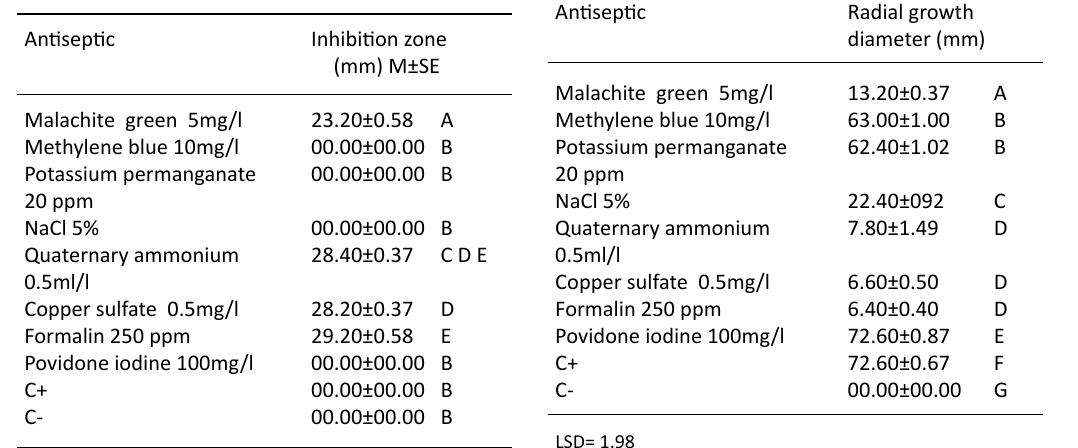
table 2. Inhibition zone diameter of B. sanguinis in the PDA media, by Agar-well diffusion method, for different antiseptics used and in comparison with control positive and negative.